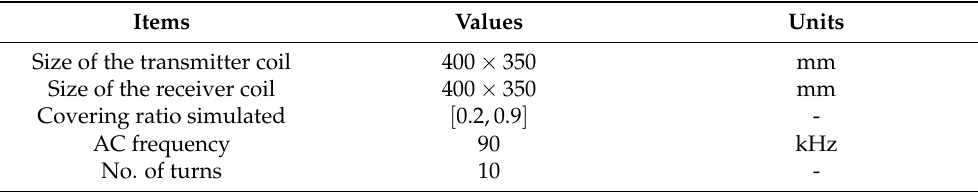
Table 3. Parameters for the rectangular coil for covering ratio simulation. Items